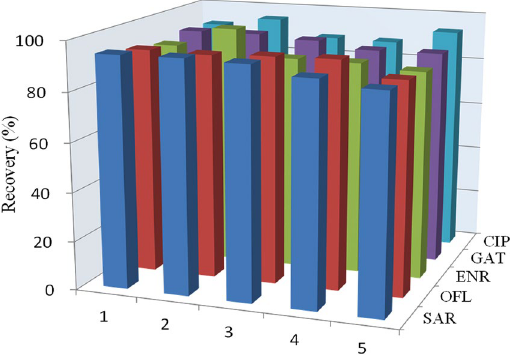
Figure 6. Removal efficiencies of the five FQ antibiotics in seawater by the PDA@GO/Fe 3 O 4 nanoparticles for five adsorption-regeneration